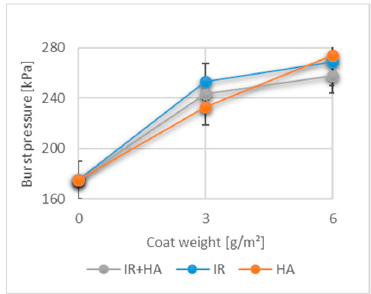
Figure 5. Burst pressure of uncoated paper and paper coated with 3 g/m 2 (1 layer) and 6 g/m 2 (2 layers) of chitosan. ( n = 15).